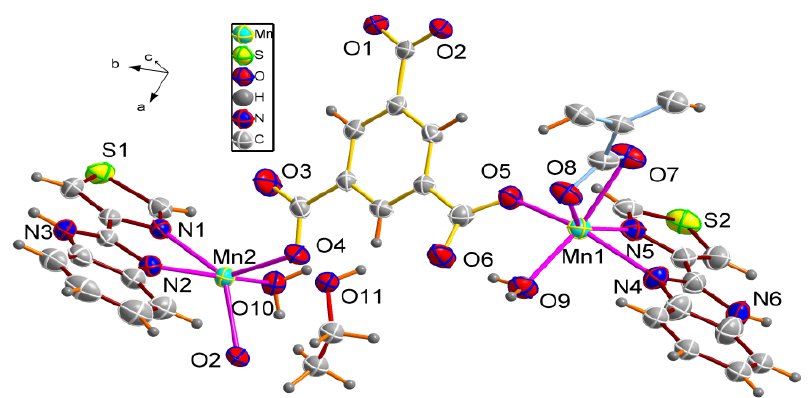
Figure 5. The coordination environment of 2